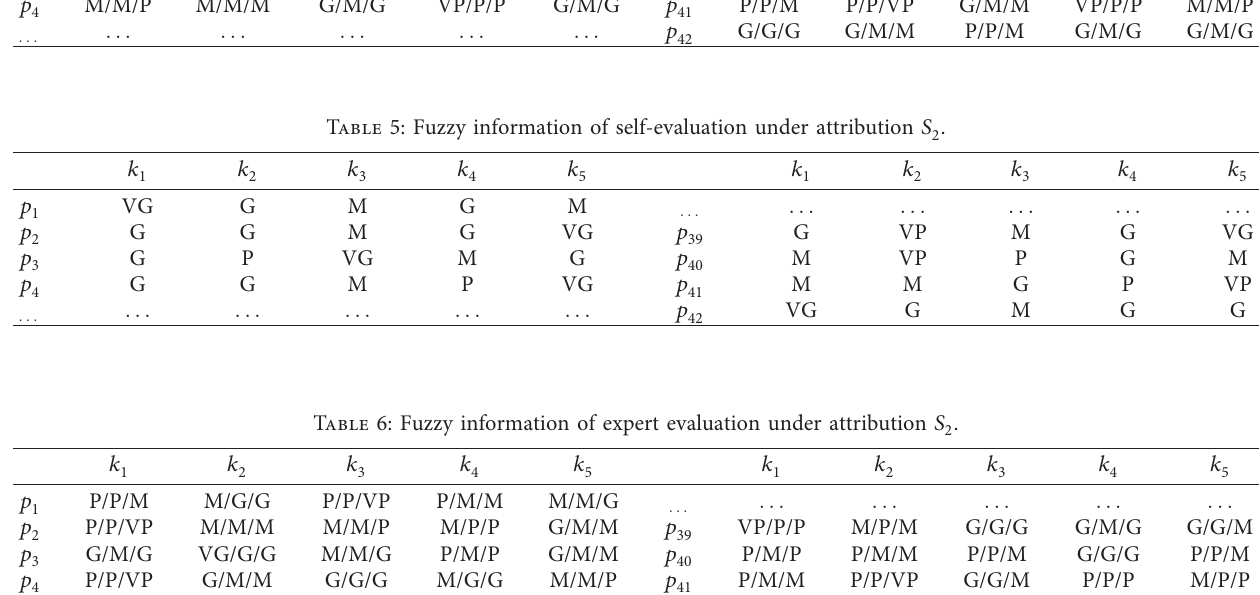
Table 7: Fuzzy information of self-evaluation under attribution S